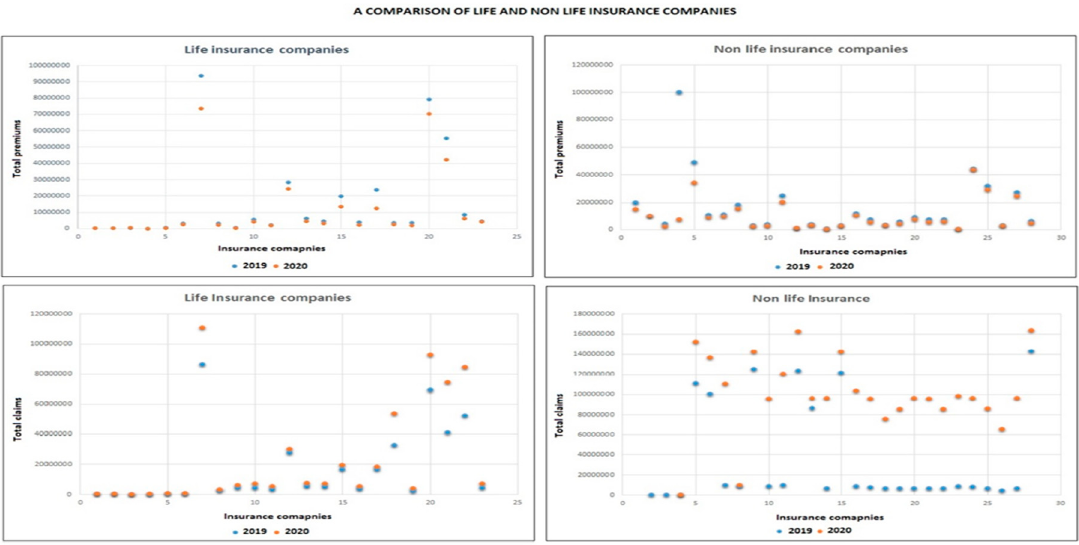
Figure 3. Life and non-life insurance companies’ performance compared.